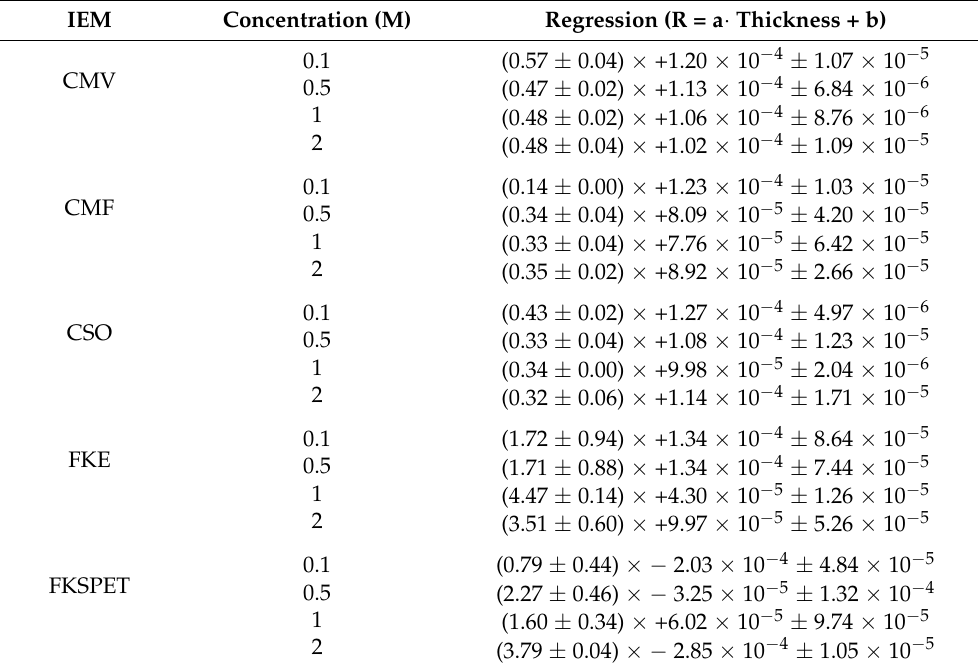
Table A4. CEMs at 313